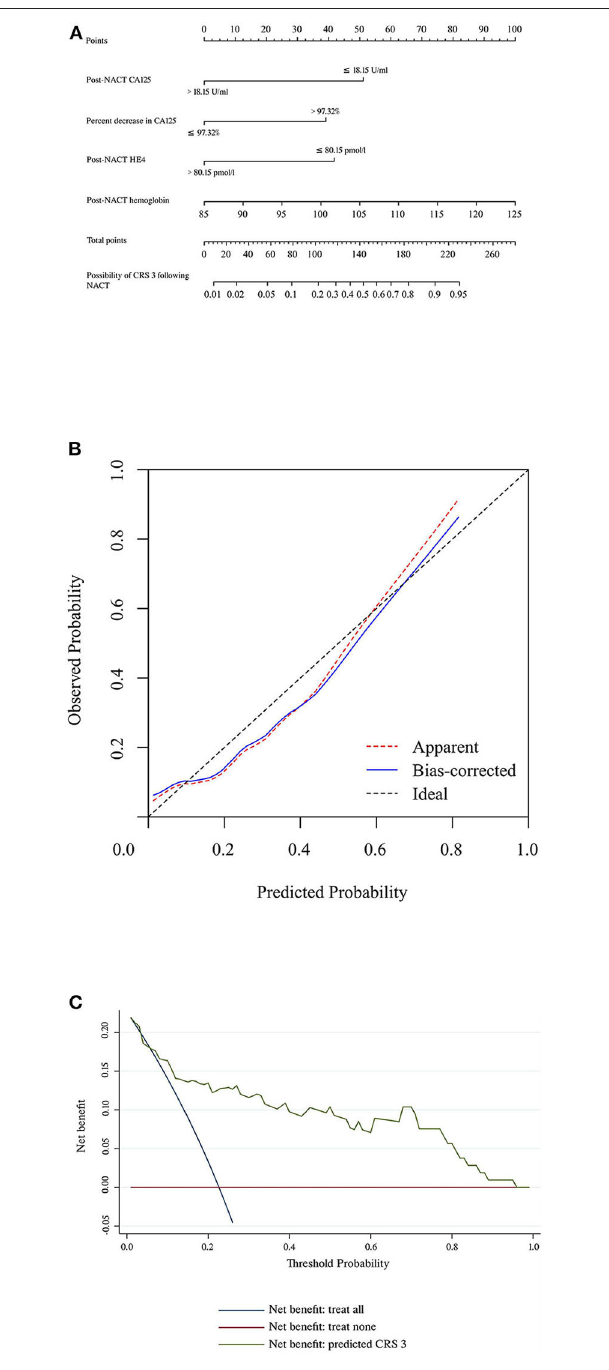
FIGURE 2 | (A) Nomogram to predict the possibility of achieving CRS 3 following NACT. (B) Calibration plot for the nomogram. (C) Results of decision curve analysis. CRS, chemotherapy response score; HE4, human epididymis protein 4; NACT, neoadjuvant chemotherapy.